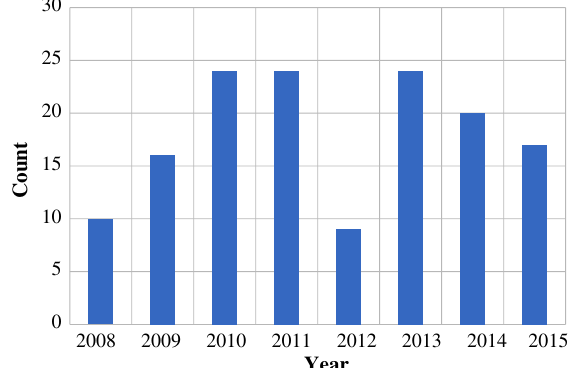
FIG. 1. Number of postdoc positions advertised in PERJobs blog, by